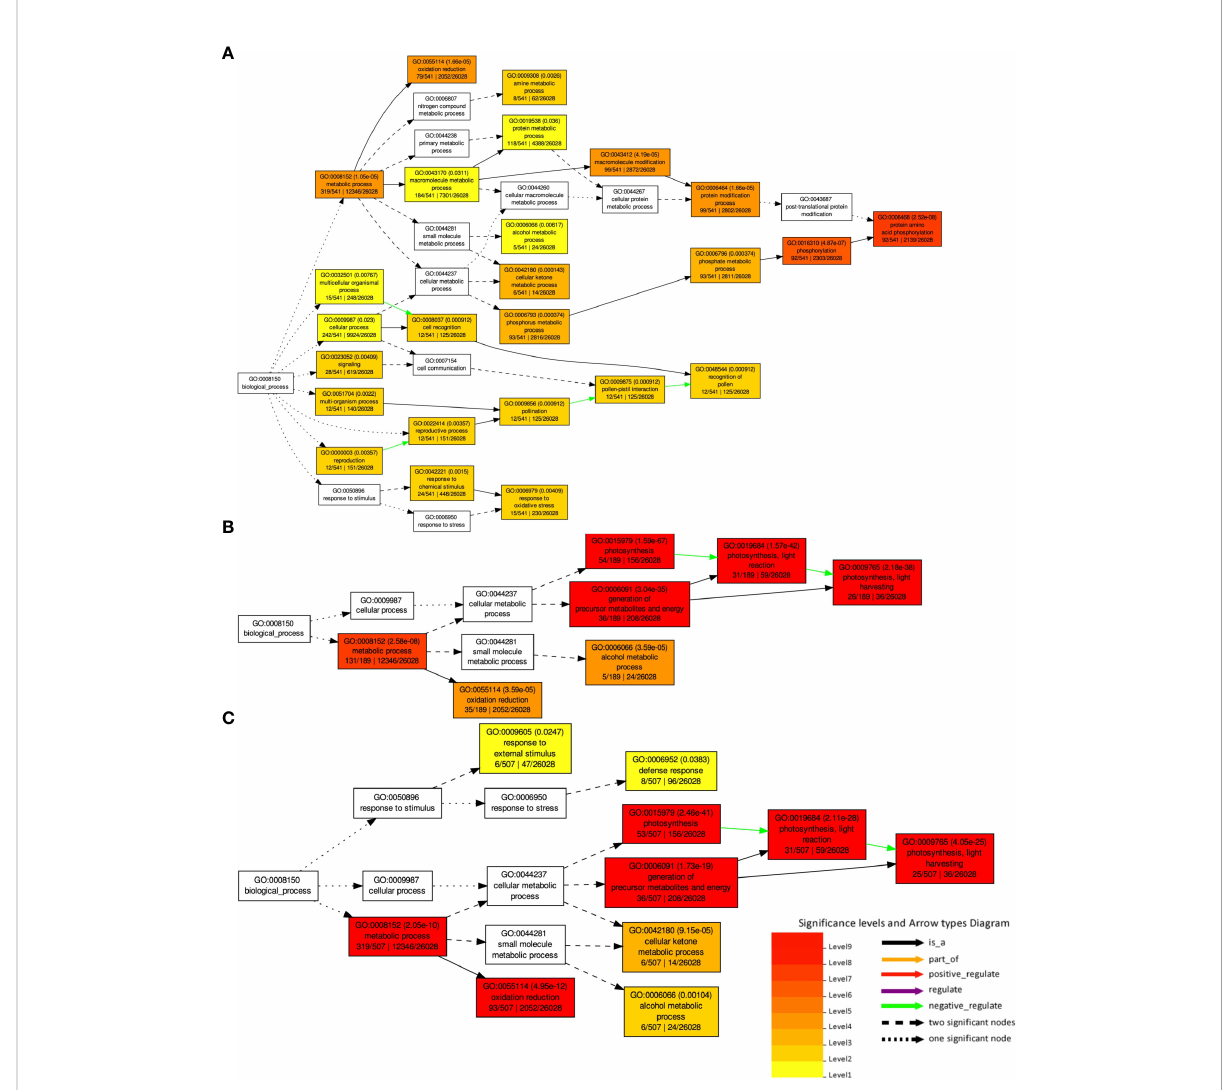
FIGURE 5 Gene ontology (GO) analysis and hierarchical classi fi cation of deferentially expressed genes DEGs by fl uopyram at 5 DAP (A) , pydi fl umetofen 5 DAP (B) and fl uopyram 10 DAP (C) . No signi fi cant GO terms were identi fi ed in pydi fl umetofen at 10 DAP. Only upregulated genes with logFC >1.0 were used in this